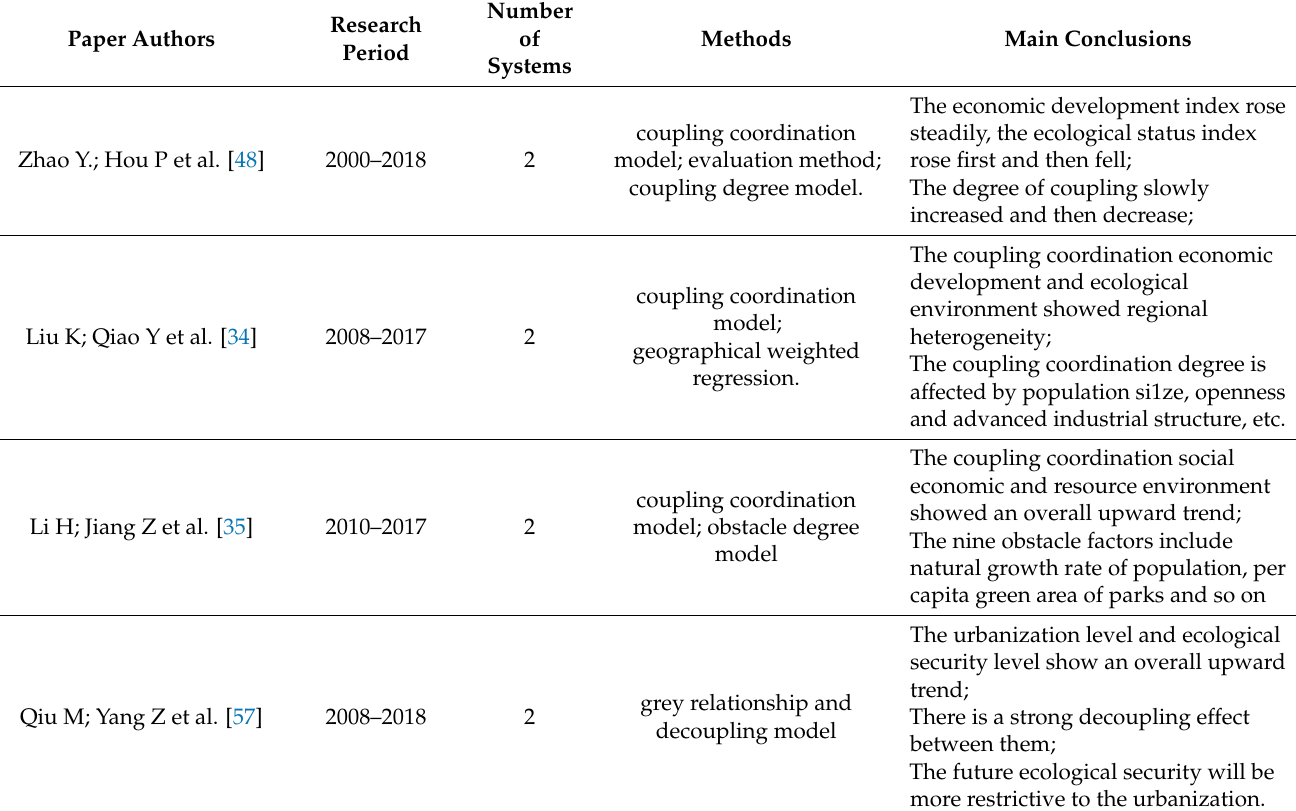
Table 11. Existing studies using the coupling coordination method in the Yellow River